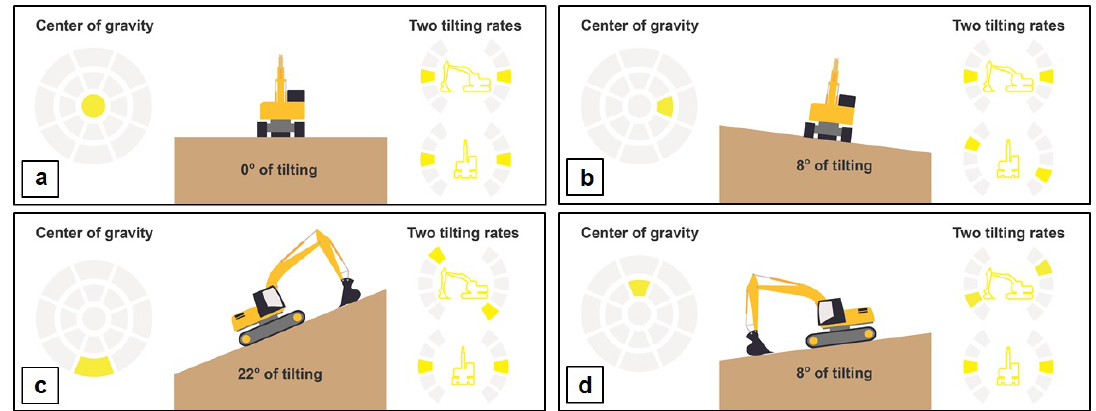
Figure 7. The images that illustrate how both concepts that indicate the machine’s balance would change. ( a ) The ground is flat, thus the machine is in a very stable position. ( b ) The machine is tilted by 8 ◦ to the right side, and thus the center of gravity moves a bit to the right side. ( c ) The excavator is climbs the slope and the steepness is 22 ◦ , thus the center of gravity moves to somewhere behind the excavator. ( d ) The excavator descends the slope and the steepness is 8 ◦ , thus the center of gravity moves a bit to the front side of the